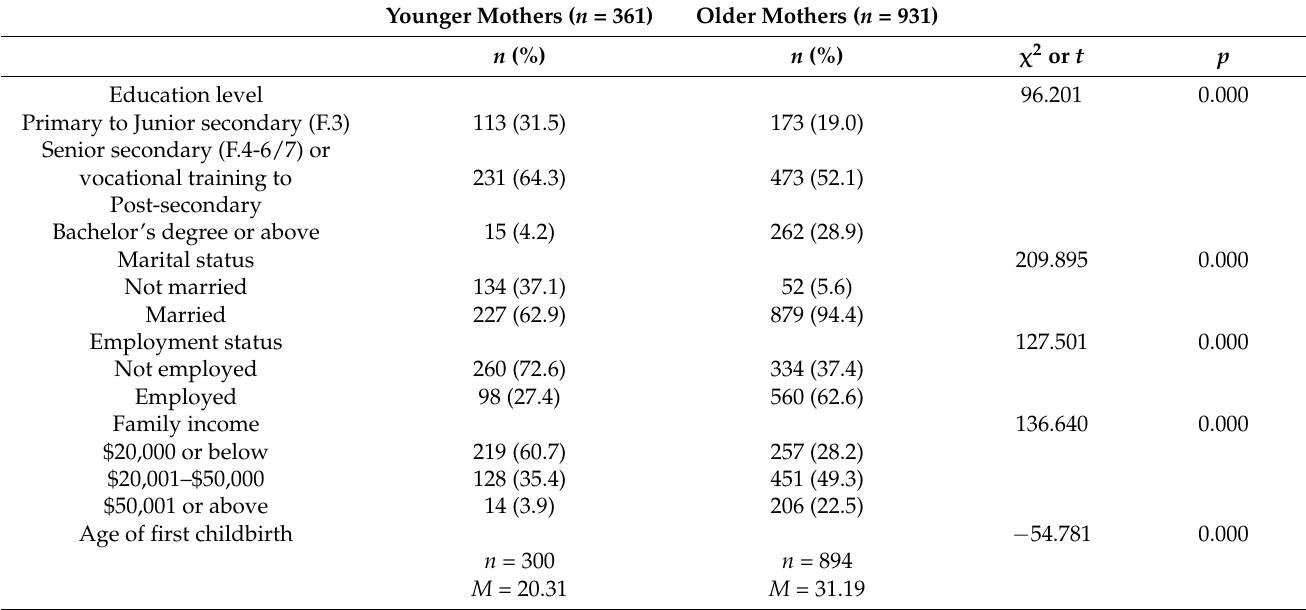
Table 2. Independent sample t tests comparing the presence of meaning in motherhood,